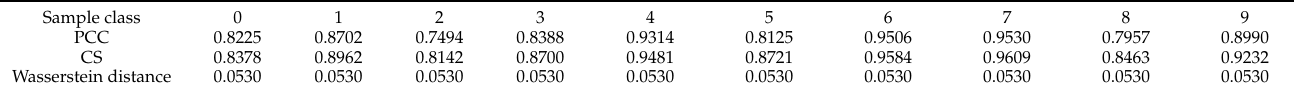
Table 5. The similarity indicators between the real data and the synthetic